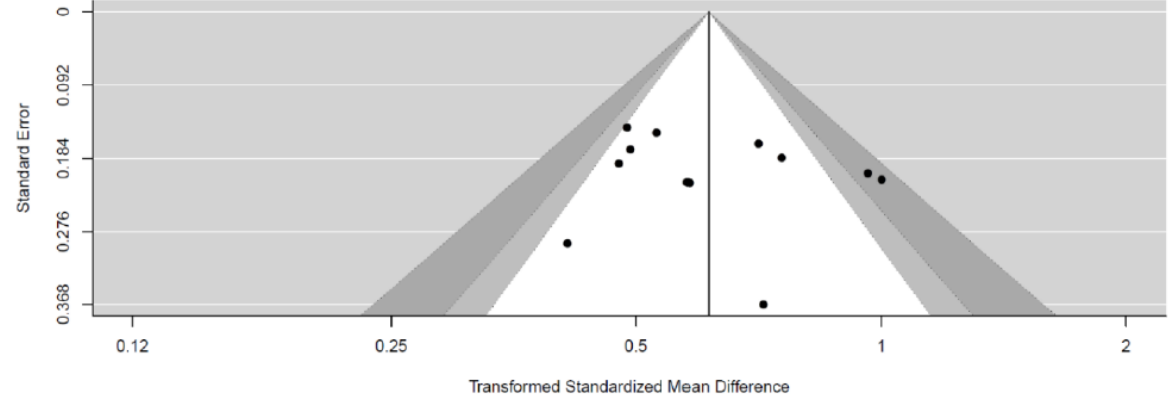
Figure 3. Check for funnel plot.